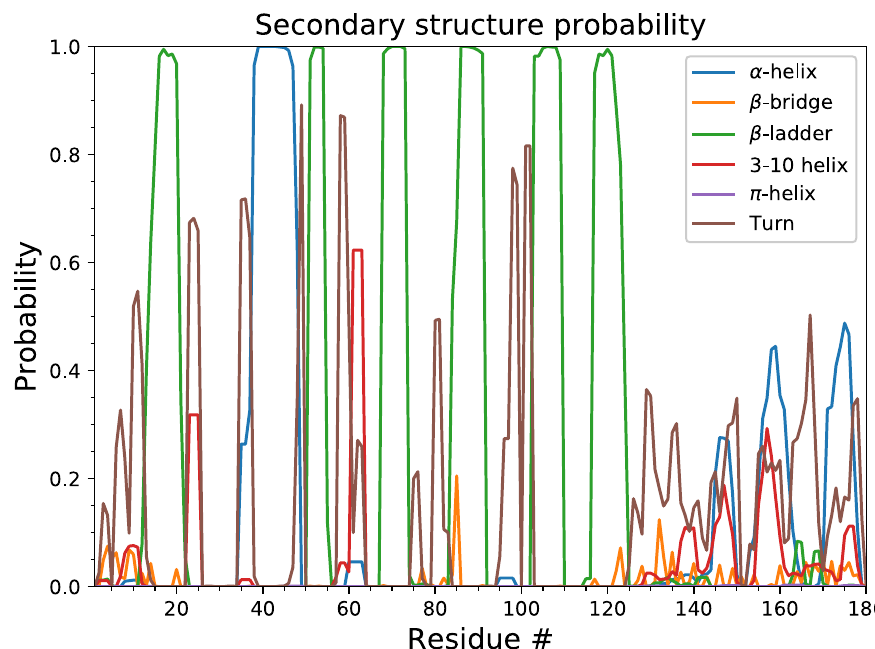
Fig 2. Secondary structure distribution of nsp1. Probabilities were calculated using the reweighting of the last 25 ns simulation trajectories.